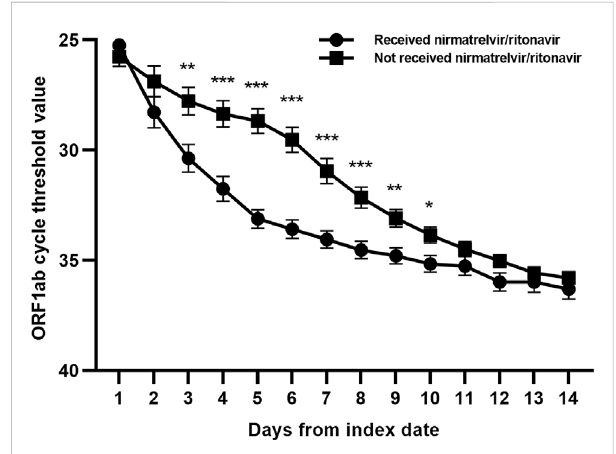
FIGURE 2 Changes of ORF1ab gene cycle threshold values in patients with SARS-CoV-2 infection and impaired kidney function with or without nirmatrelvir/ritonavir therapy.Data are mean (standard error of mean). *** p < 0.001; ** p < 0.01; * p <